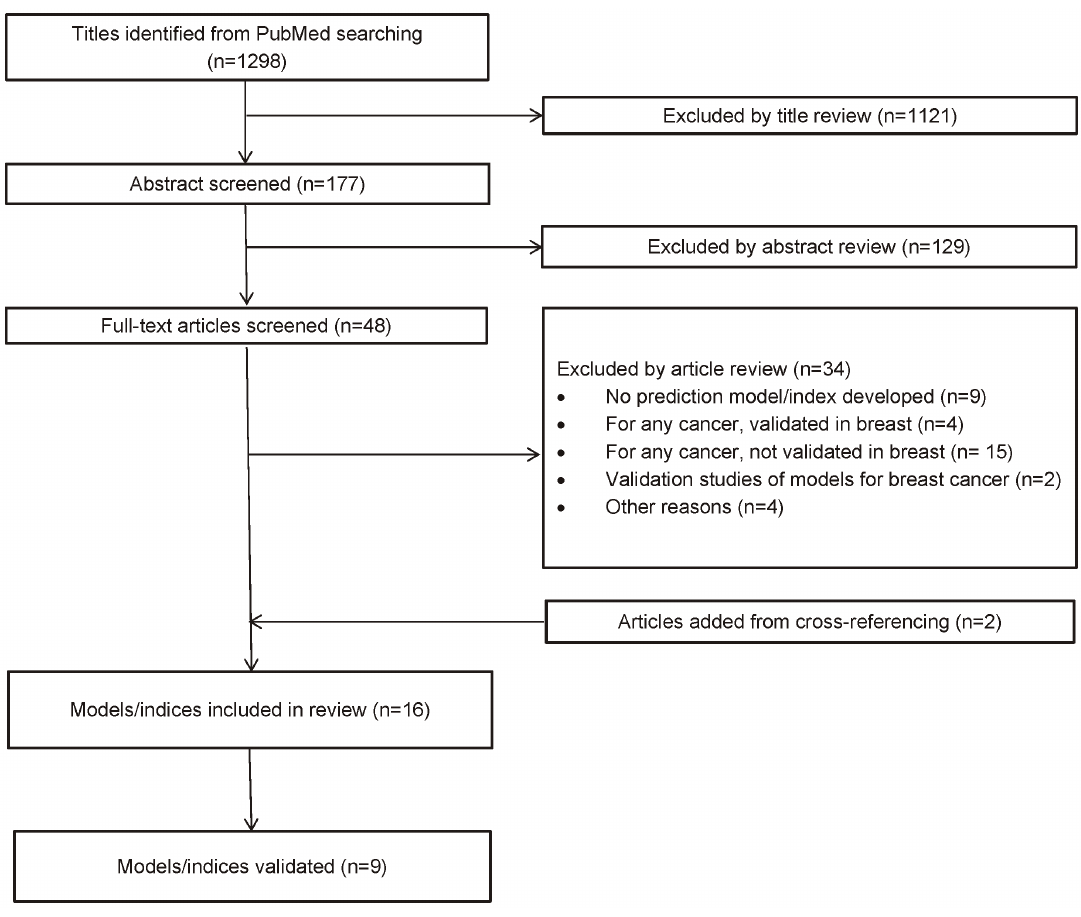
Figure 1. Flow chart of study selection process. n= number of studies.